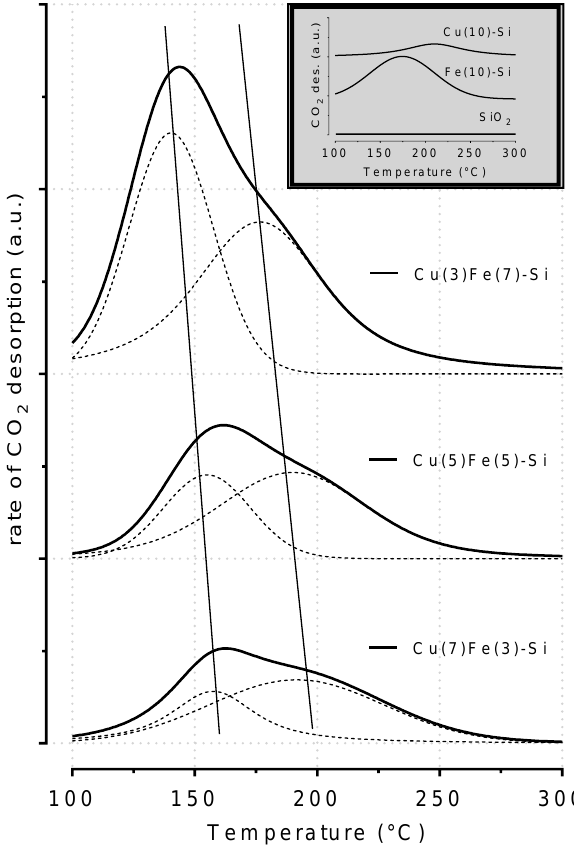
Figure 6. CO 2 -TPD profiles of the Cu(x)Fe(y)-Si catalysts. In the inset, the TPD profiles of the bare SiO 2 sample along with mono-metallic Cu/SiO 2 and Fe/SiO 2 samples are